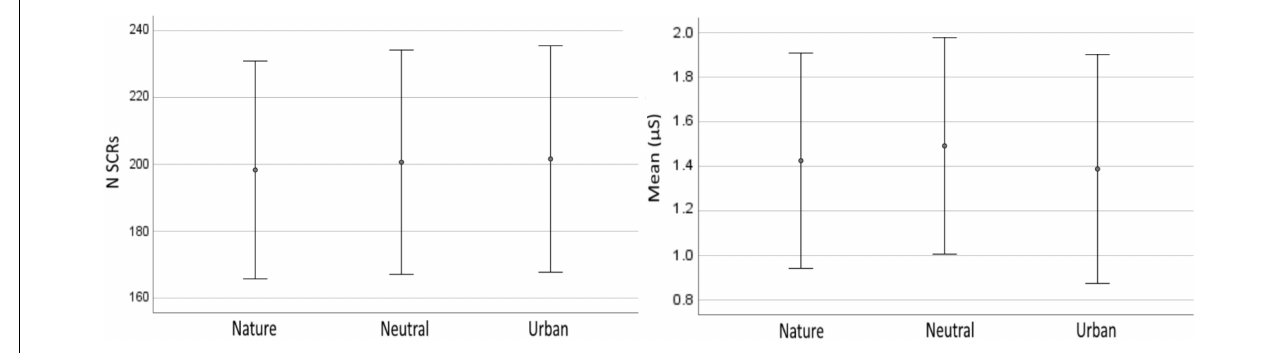
FIGURE 9 | Electrodermal activity in neutral, nature, and urban experimental conditions. Error bars show standard deviations (SD).